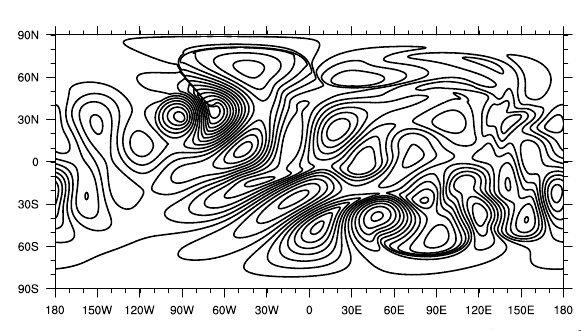
Figure 7. TC5 vorticity contours for low and high uniform resolu- tions with constant-coefficient hyperviscosity. The contour spacing is 5 . 0 × 10 − 6 s − 1 . A spherical mountain approximately 30 ◦ in di- ameter is centered at 30 ◦ N and 90 ◦